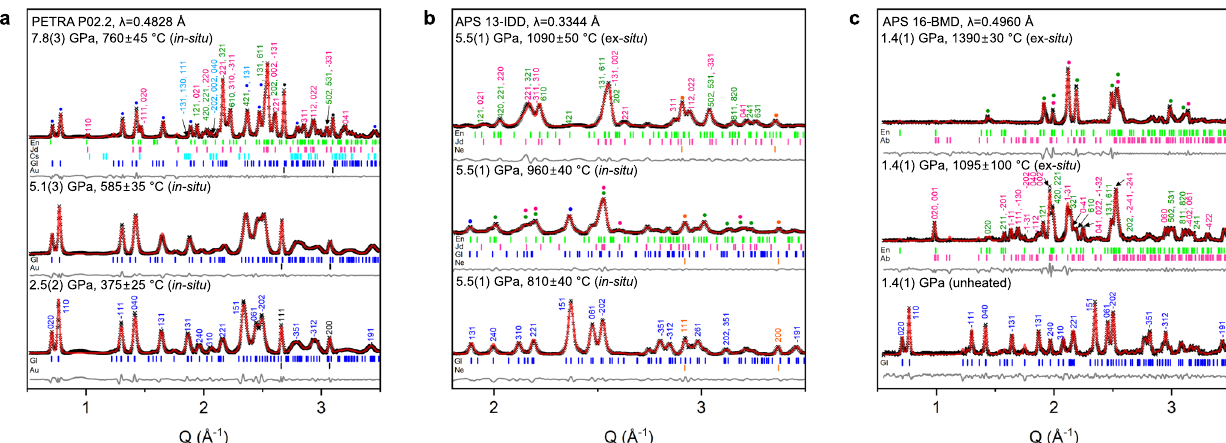
Fig. 2 XRD patterns of glaucophane at P – T conditions of three different subduction geotherms. Representative X-ray powder diffraction patterns of glaucophane along the P – T conditions of a cold subduction zone, b warm subduction zone, and c high thermal gradients in the Proterozoic tectonic settings. The experimental data and pro fi le fi ts using the LeBail method 65,66 are shown in black symbols and red lines, respectively, with difference curves in gray lines. The backgrounds of the X-ray diffraction patterns have been subtracted prior to the data being fi tted (see Supplementary Fig. 3 for the original patterns). Phase abbreviations: glaucophane (Gl), enstatite (En), jadeite (Jd), albite (Ab), coesite (Cs), gold (Au), and neon